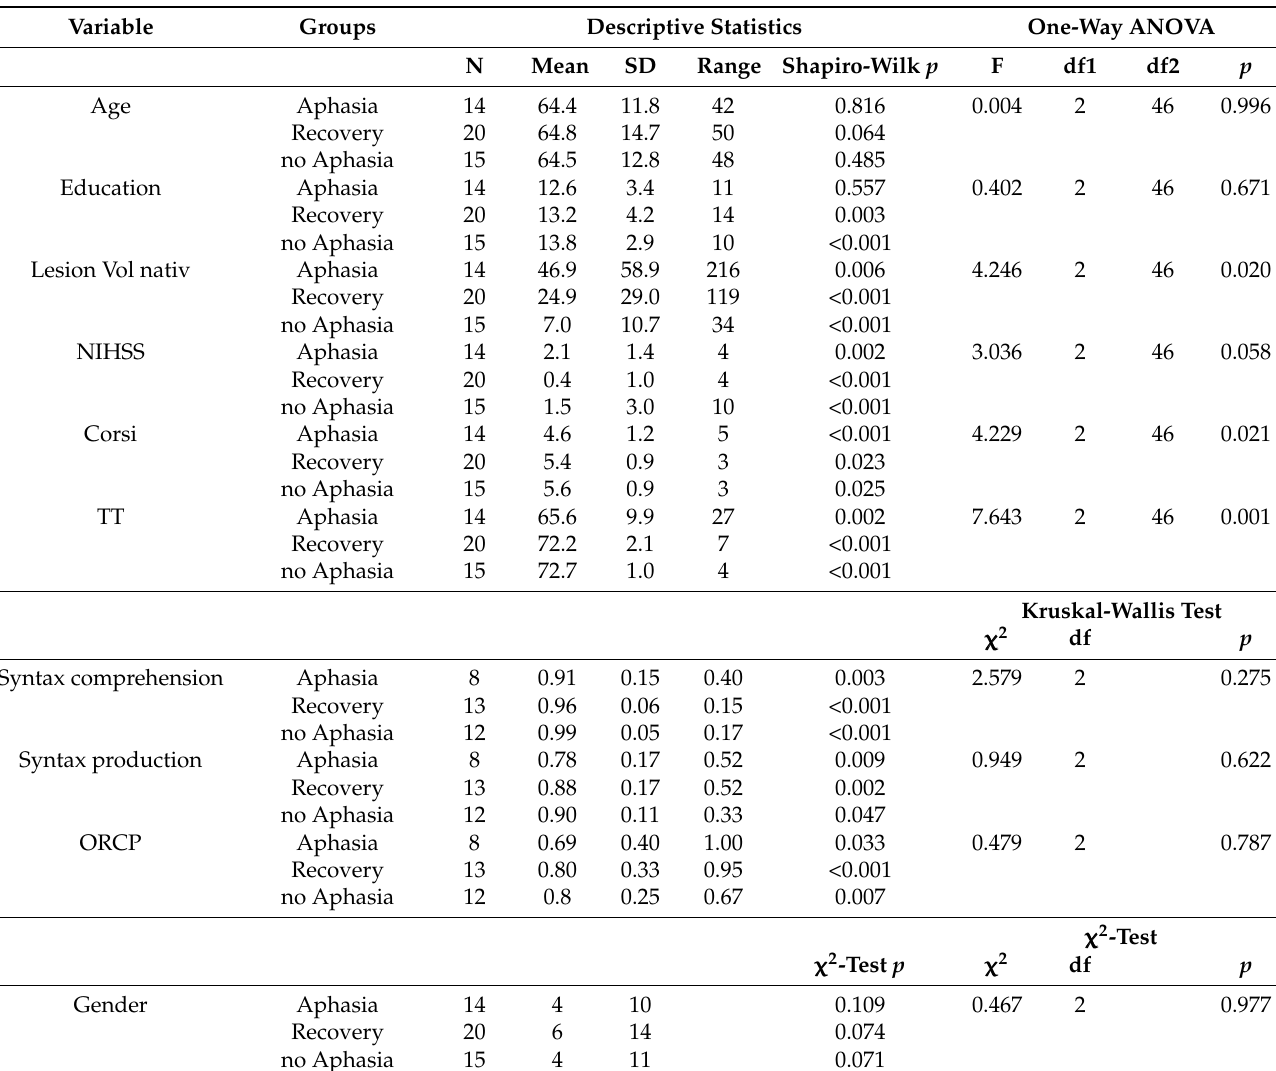
Table 1. Patients’ demographic and clinical